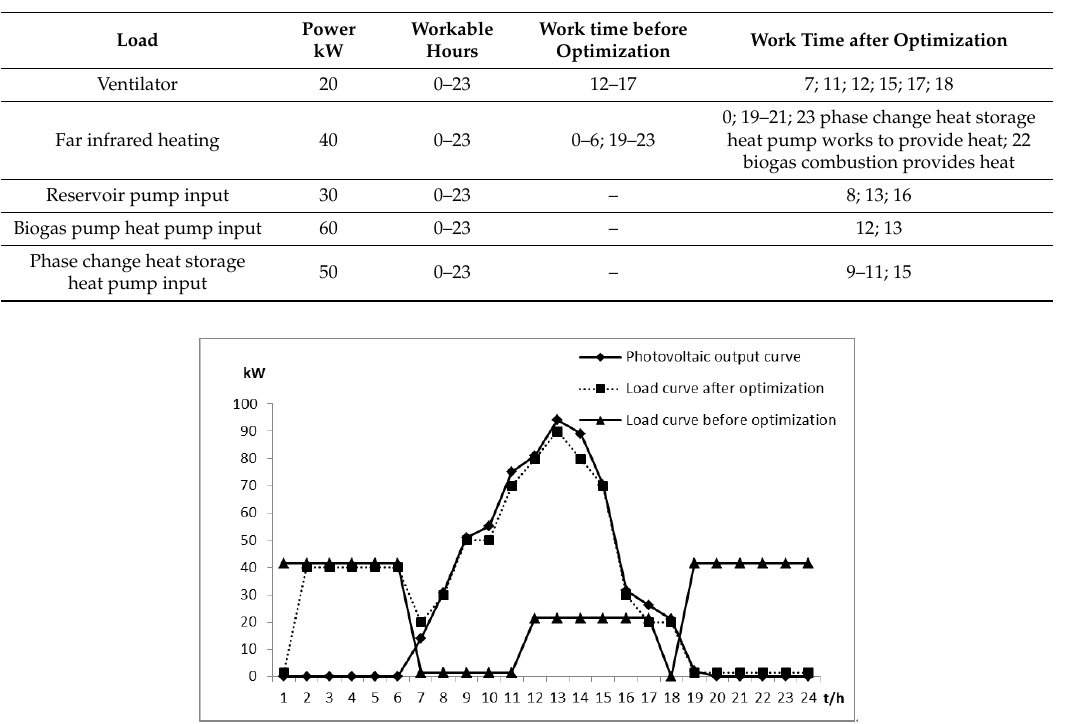
Table 5. Timetable of loads and energy stores working time before and after optimization on a cloudy winter day after a rainy day.